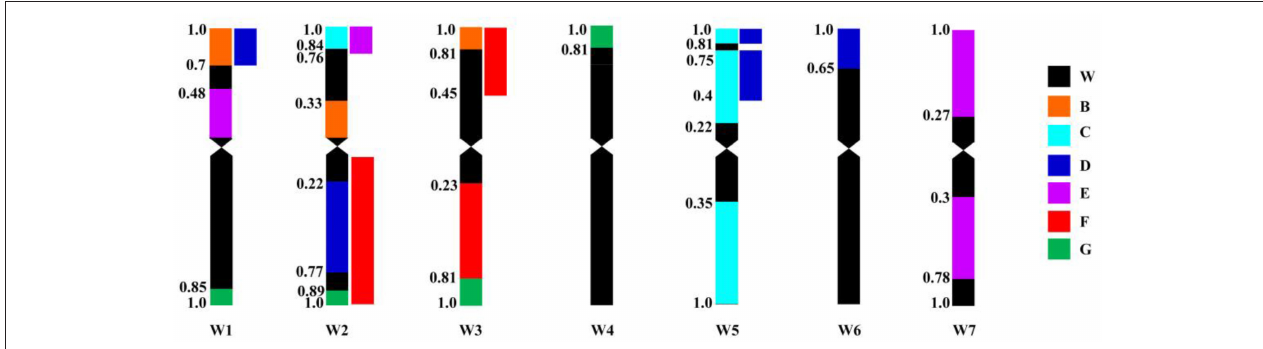
FIGURE 4 | Schematic patterns of Ae. caudata chromosome rearrangement compared to wheat chromosomes as a reference revealed by PLUG markers physically mapped. Ae. caudata chromosomes were marked as B, C, D, E, F and G. W means wheat, W1–W7 represents wheat chromosome group 1–7, respectively. Define the lengths from centromere to both chromosome ends are 1, the values shown on the left of the chromosomes are fragment length